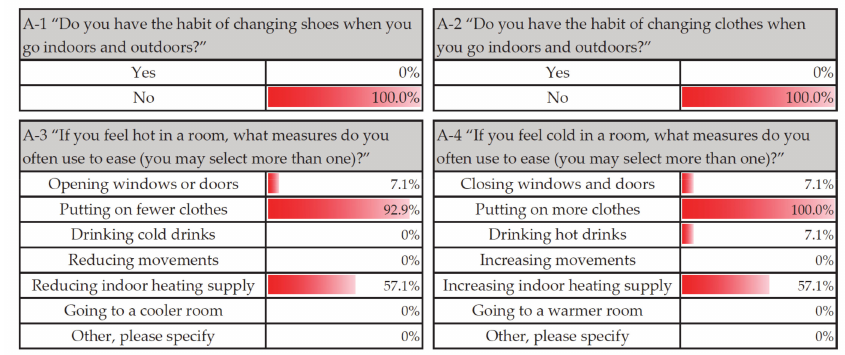
Figure 3. Personal living habits in winter of volunteers (N = 14).